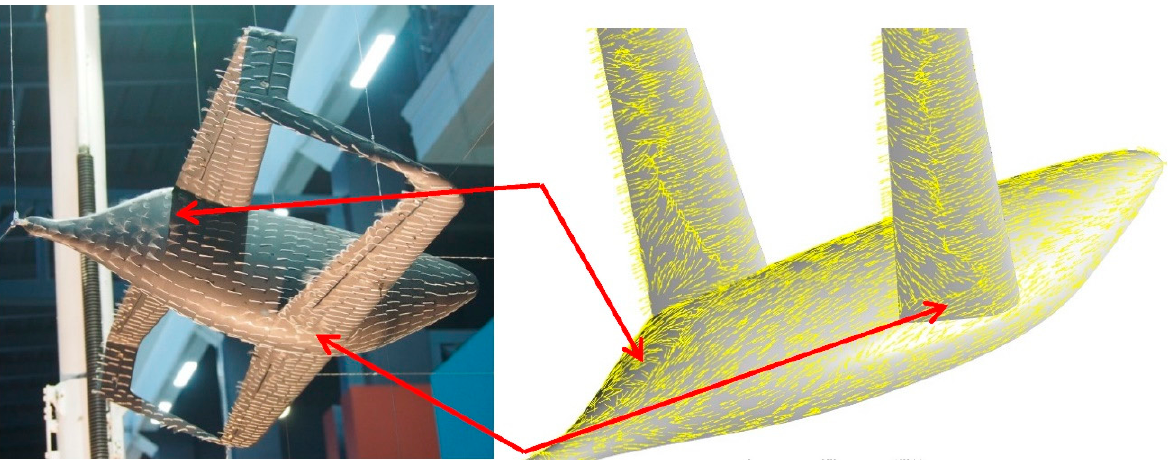
◦ , β = 0 ◦ , cruise configuration (high-lift devices Figure 7. Test conditions: α = 15°, β = 0°, cruise configuration (high-lift devices retracted). Figure 7. Test conditions: α = 15